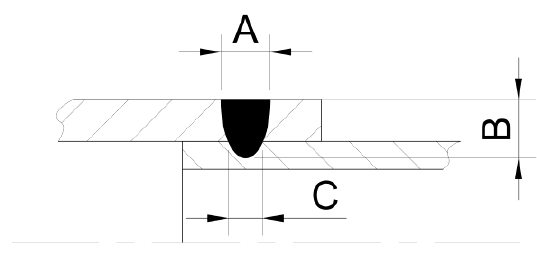
Figure 2. Schematic diagram of the analysed weld.